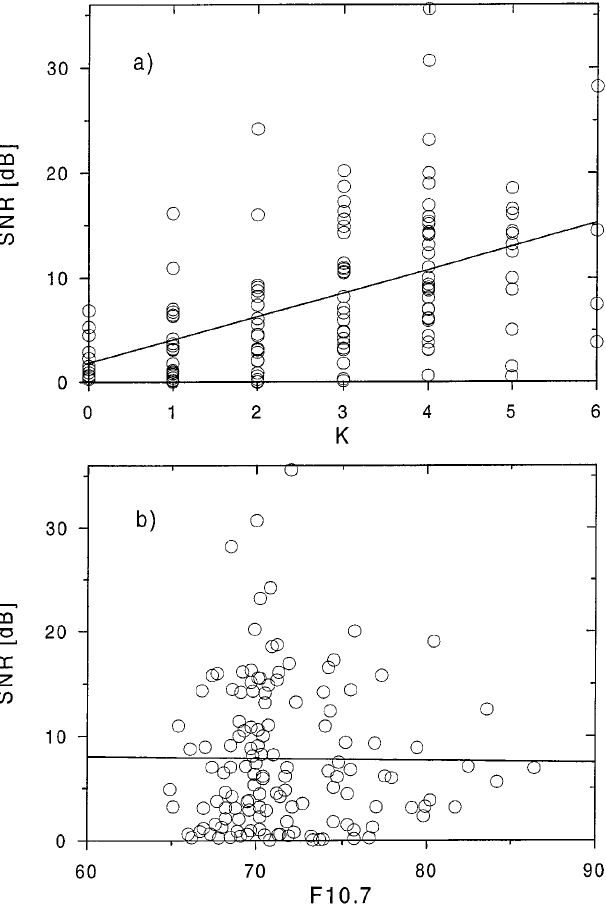
Fig. 2a, b. Dependence of SNR (83.0–87.5 km, Andenes) on a geomagnetic activity K and b on solar activity F10.7 for the time interval 0–3 UT using data for June and July 1994–1997. The straight lines are the regression lines